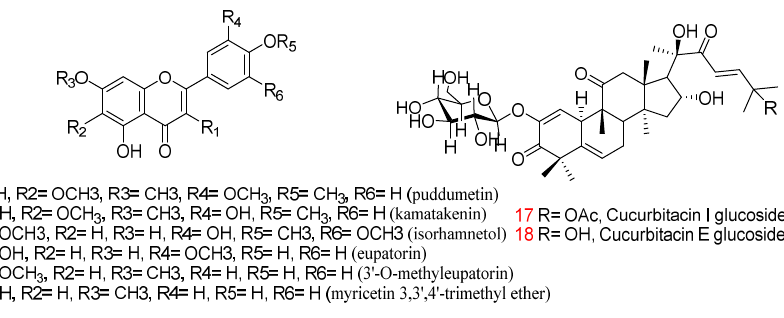
Figure 4. Structures of compounds 11–18 with anti-cancer activity.